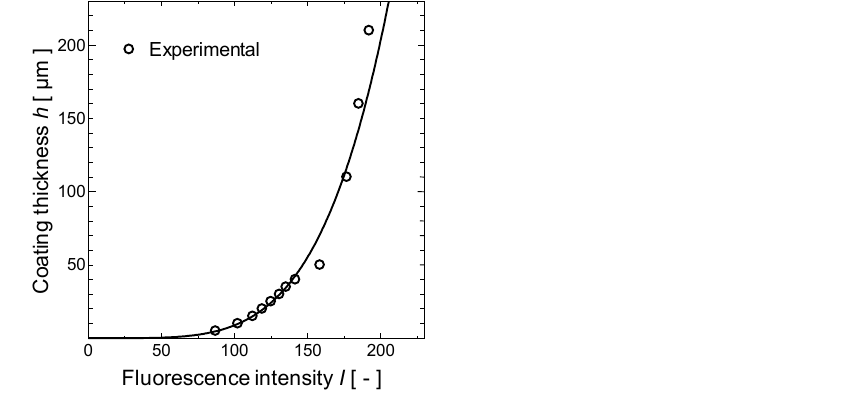
Figure 3. Calibration curve showing the coating film thickness in relation to the fluorescence inten- sity.